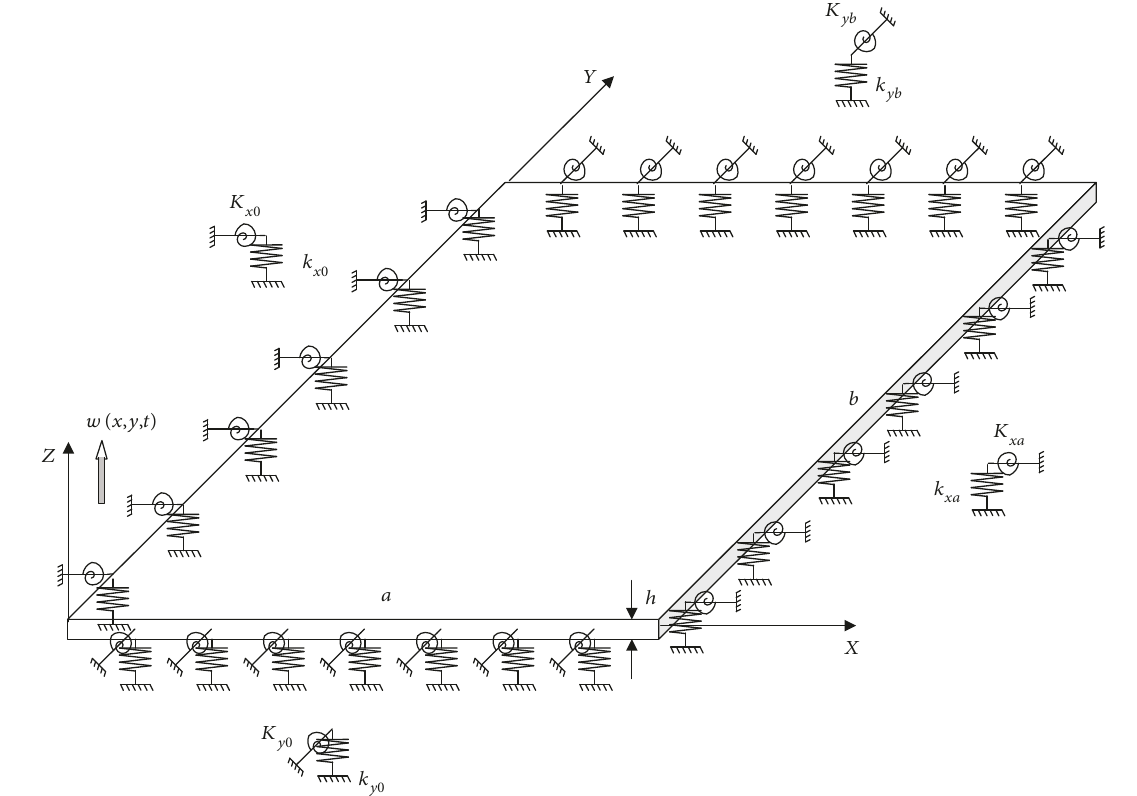
Figure 1: A rectangular plate with elastic constraints at all